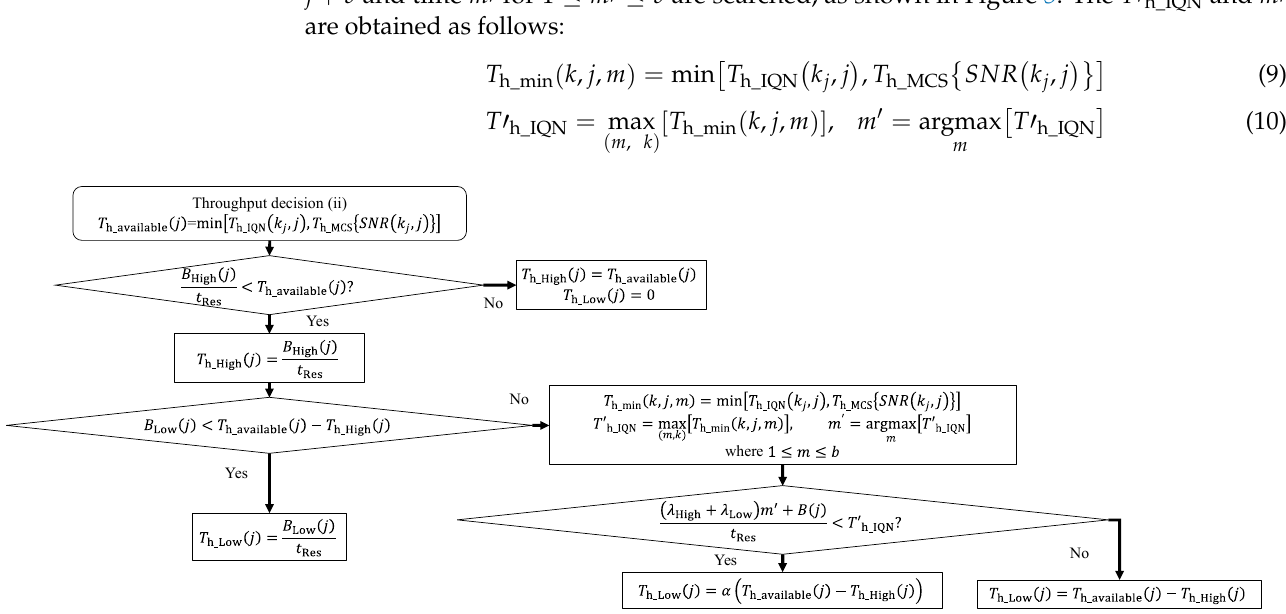
Figure 5. Proposed throughput decision flowchart at vehicle.